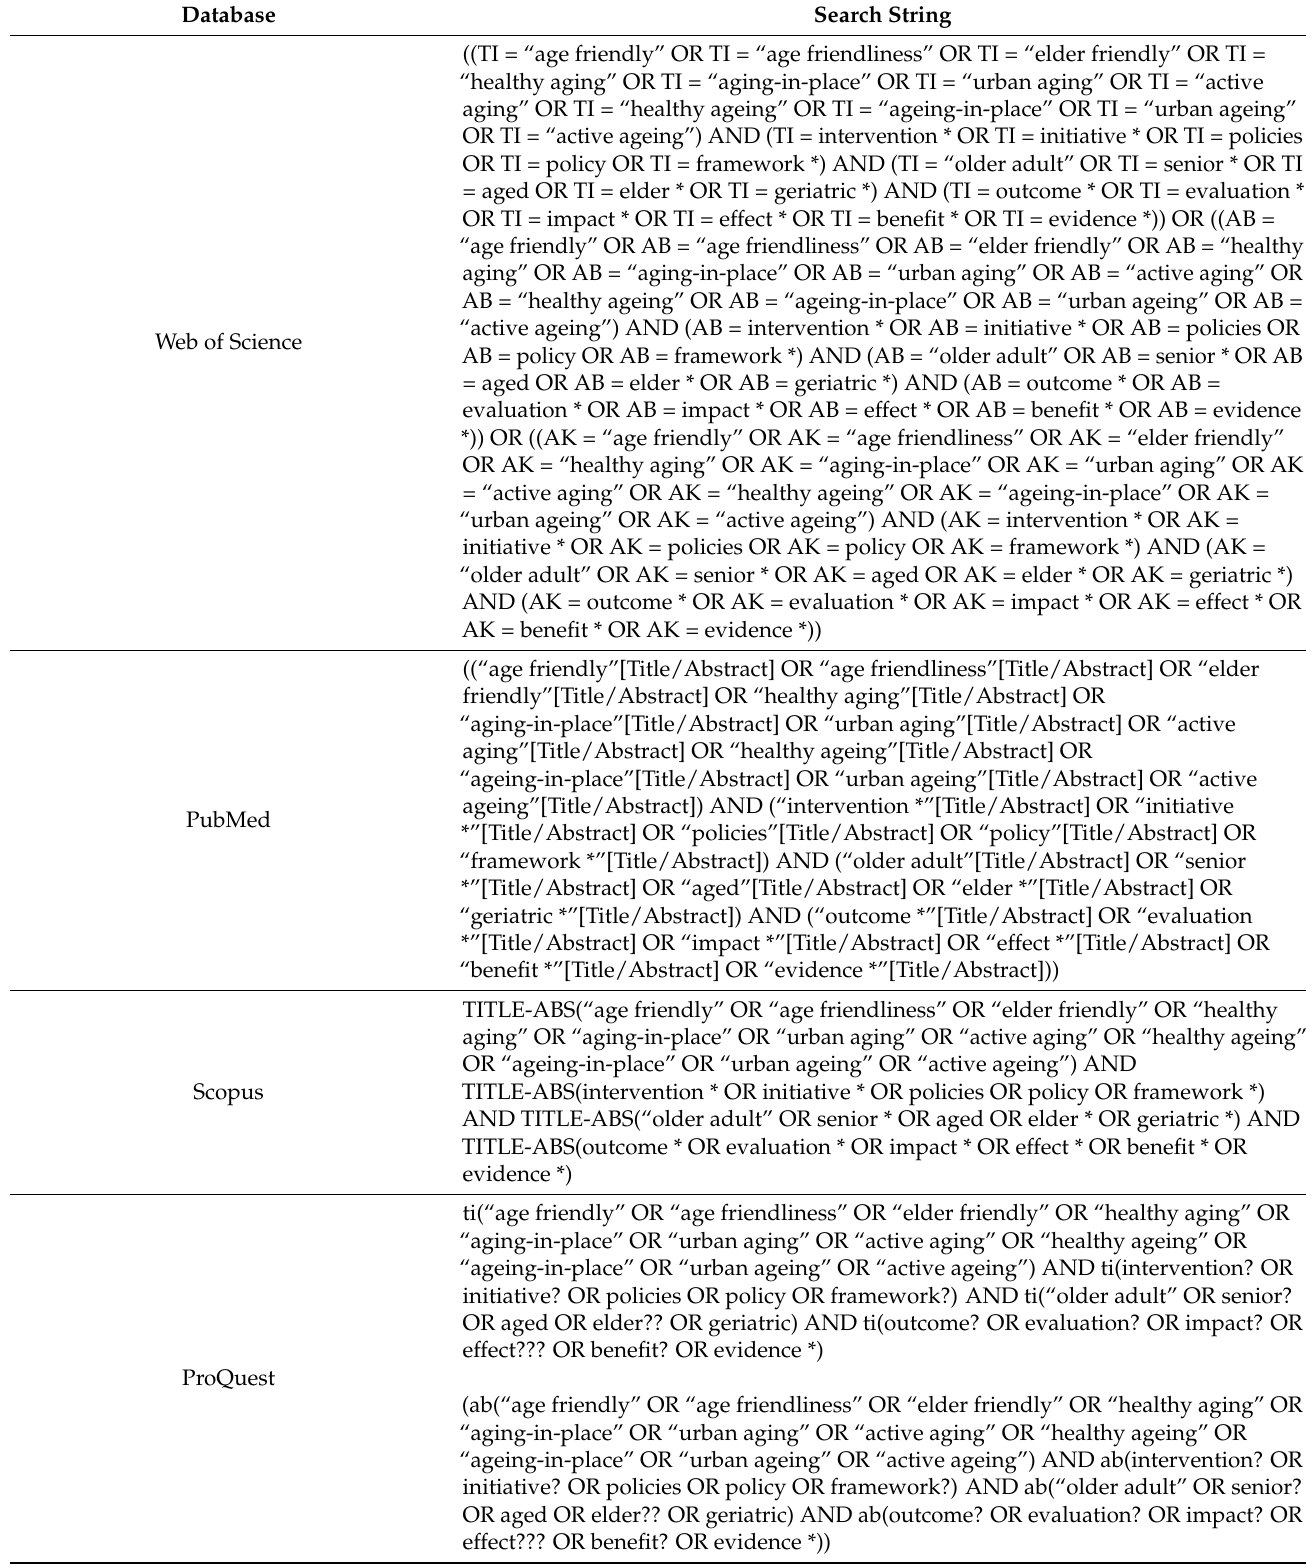
Table A1. Search strings used in different bibliographic